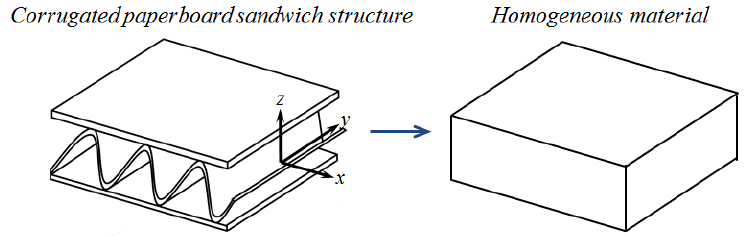
Figure 17. Simplified model of A / F-SW corrugated paperboard.